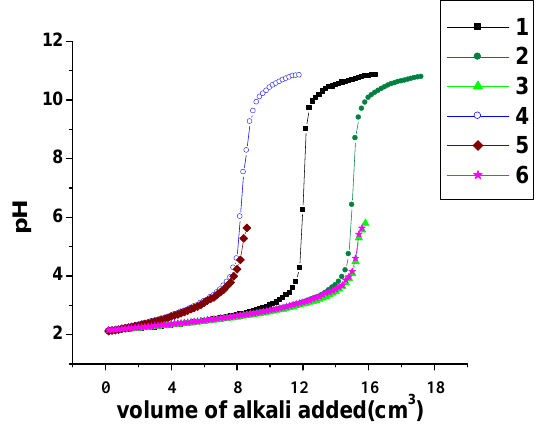
Figure 2 : Potentiometric titration curves of binary (1:1) and ternary (1:1:1) complexes of Salicylic acid and Vitamin B 3 ( I =0.15 M NaNO 3 at 37.0±.2 ⁰ C); 1 . HNO 3 2 . HNO 3 + Salicylic 3 . HNO 3 + Salicylic+ Pb(NO 3 ) 2 4 . HNO 3 + Vitamin B 3 5 . HNO 3 +Vitamin B 3 + Pb(NO 3 ) 2 6 . HNO 3 +Salicylic+Vitamin B 3 + Pb(NO 3 )